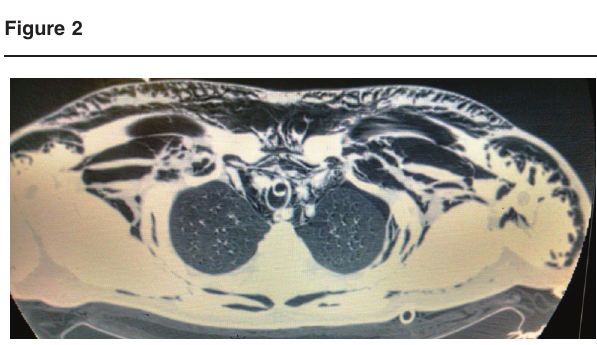
Computed tomography thorax showing pneumomediastinum and subcutaneous